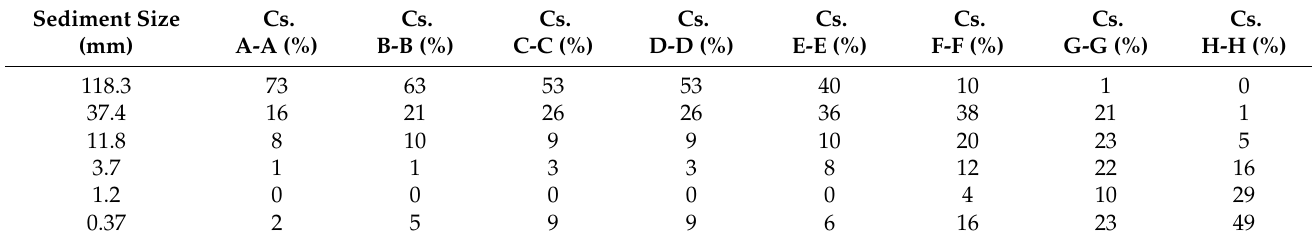
Table 1. The average sediment-size distributions in the specified cross-sections of the Unazuki Reservoir shown in Figure 1c. Cs. is an abbreviation for